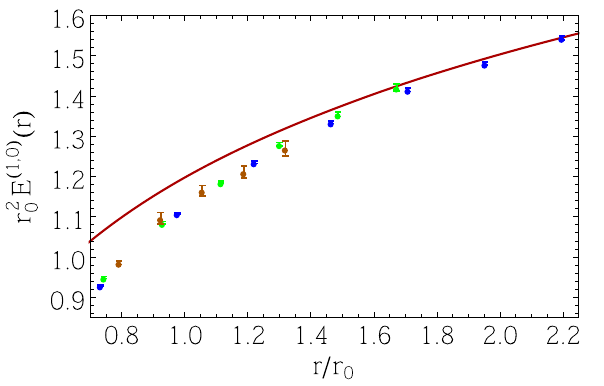
Fig. 10 Comparison of the lattice data with the predictions from effec- tive string theory at long distances for E